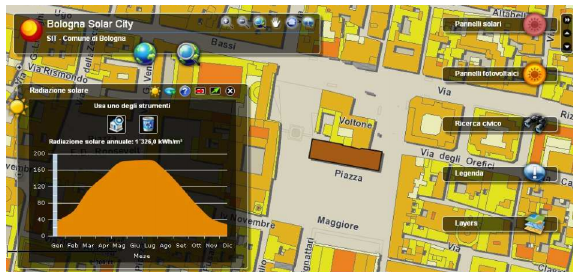
Figure 1: Web application Bologna Solar